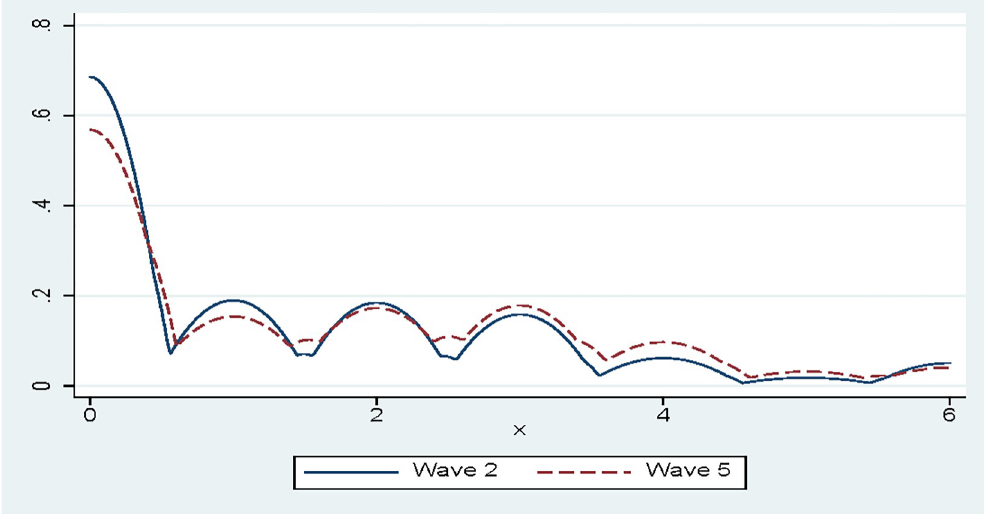
Fig 3. Kernel density plot: PHQ-2 waves 2 and 5. Source: NIDS-CRAM waves 2 and 5, weighted. in model. Pre-pandemic mental distress is also significant in model 3. This points to a signifi- cant association between mental distress and vaccine distrust resulting in multicollinearity in models 1 and 2. Other results emerging are that age and education reduce vaccine hesitancy. Black African population group and those who have experienced hunger have on average lower hesitancy. Our findings are in line with other studies like Paul et al. [15], Thunstrom et al. [17], Sher- man et al. [45], and Williams et al. [46] that suggest that the largest behavioural and attitudinal